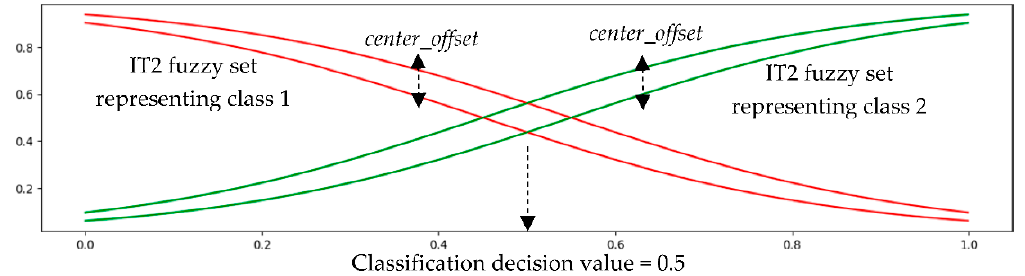
Figure 6. IT2 fuzzy sets used in the rule conclusions.